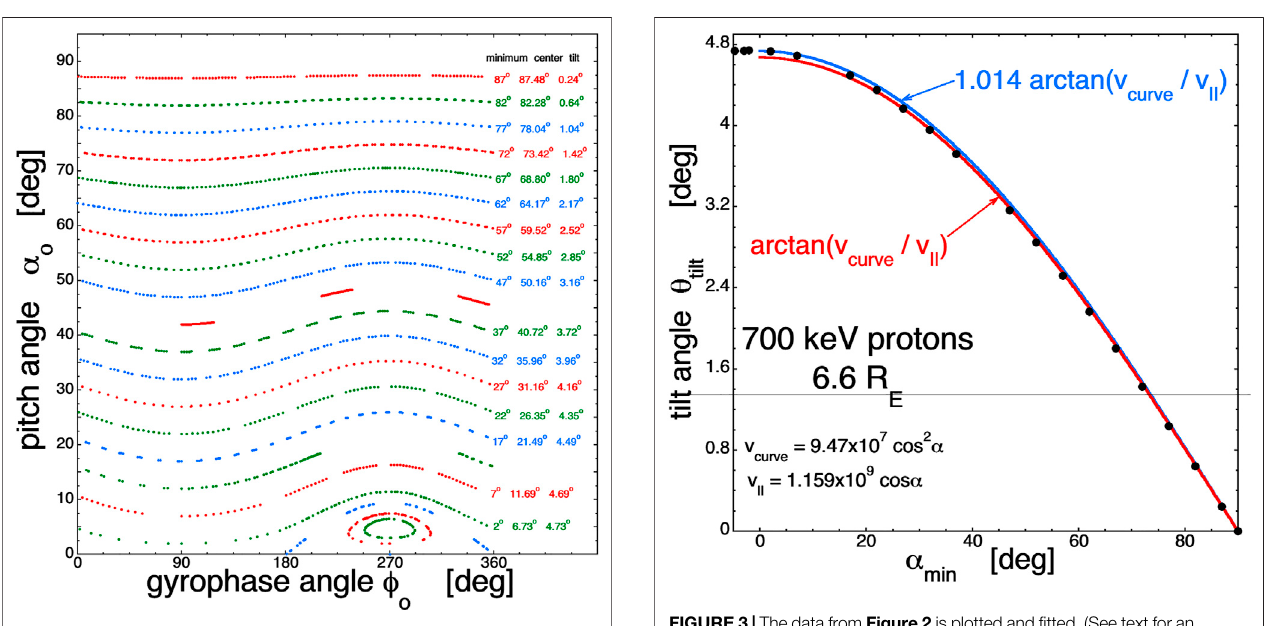
FIGURE2| The α o and ϕ o coordinatesofthenorthward-goingequatorial crossings of twenty 700-keV protons at geosynchronous orbit ( Figure 1 ) are plotted in Cartesian fashion.